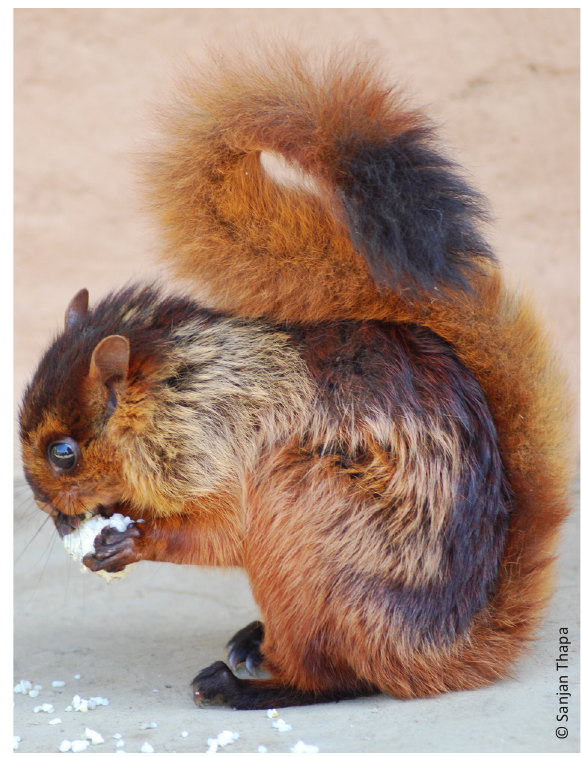
Image 2. Red Giant Flying Squirrel Petaurista petaurista